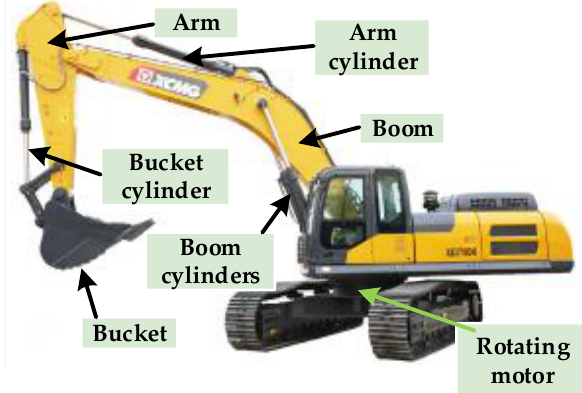
Figure 2. 37 tons hydraulic excavator.